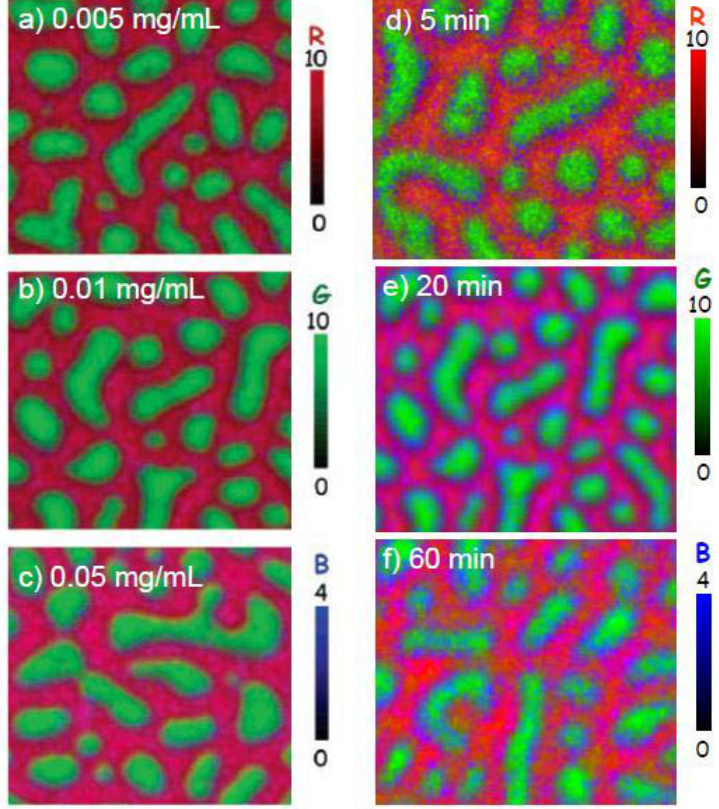
Figure 4. X-PEEM color coded composite maps of HSA adsorbed to PS/PMMA films. (Left panels) HSA concentration dependence: (a) 0.005 mg/mL, (b) 0.01 mg/mL, (c) 0.05